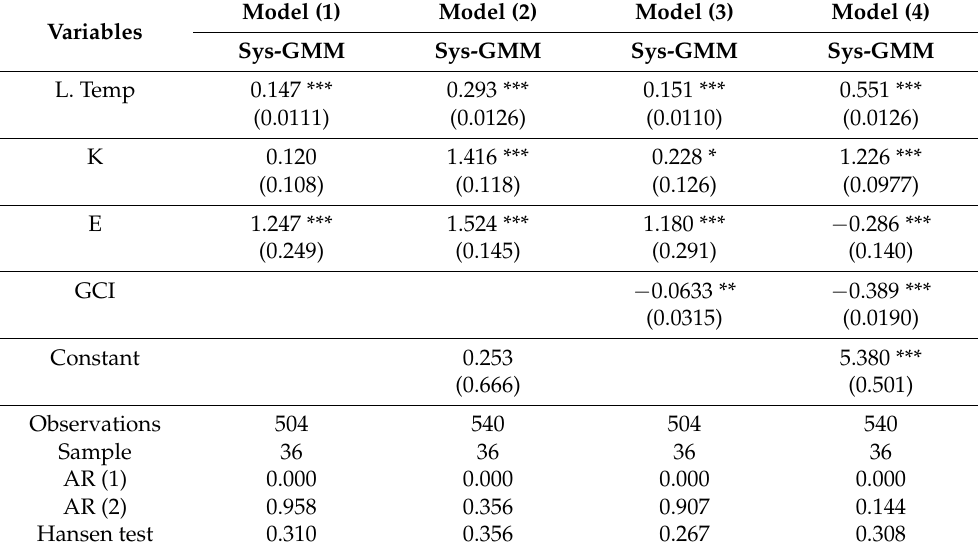
Table 4. The climate change function